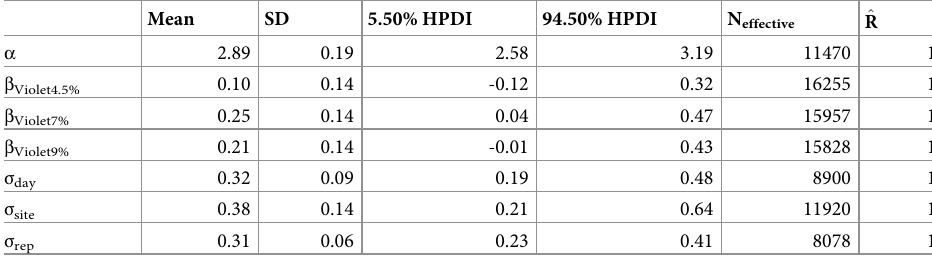
Table 3. A summary of posterior distributions for the coefficients estimated by analysis of experiment 2 data.